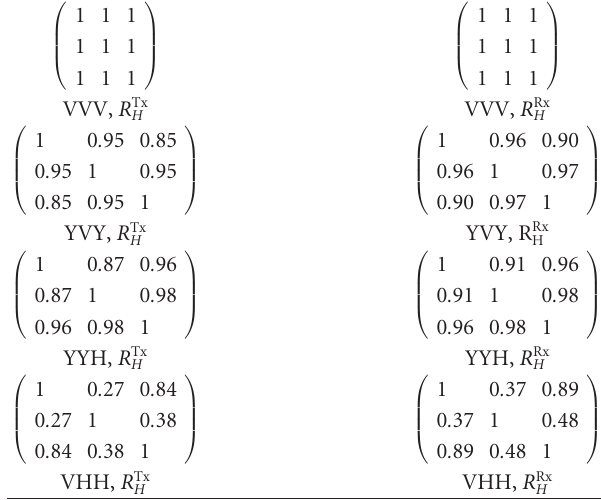
Table 4: Correlation matrix of direct path power analysis for di ff erent polarization schemes in LOS environment. ⎛